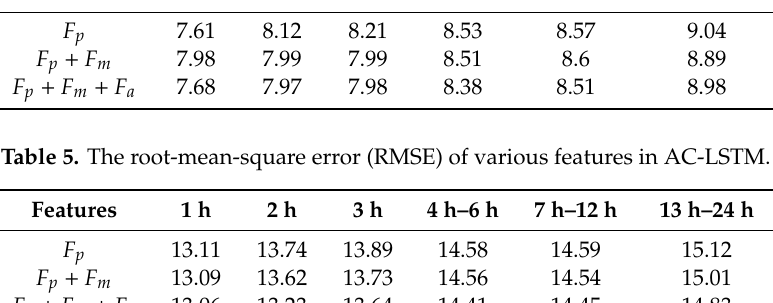
Table 4. The mean absolute error (MAE) of various features in AC-LSTM. Features